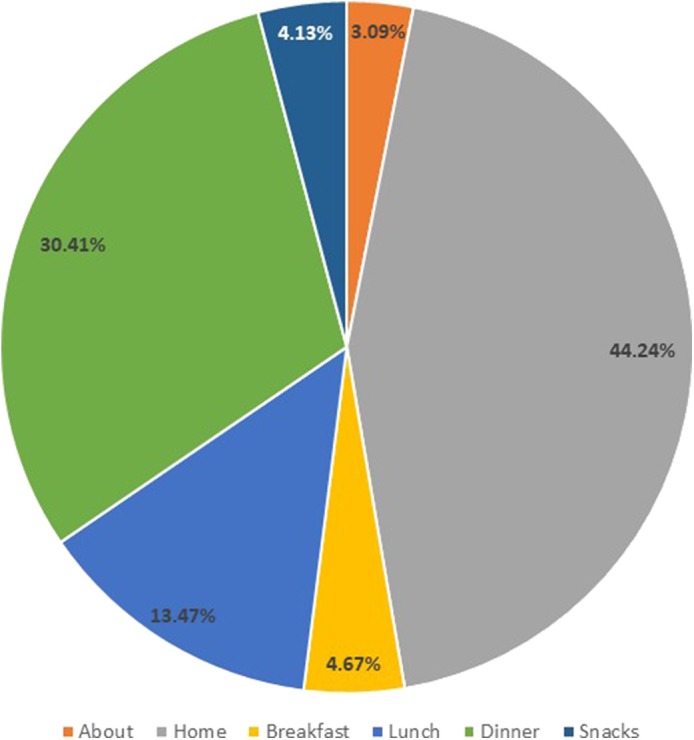
Frequency of use (%) for various areas of the study app.